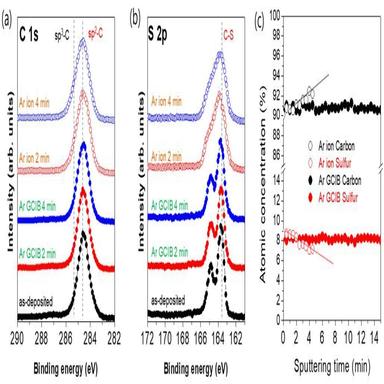
(a) C 1s and (b) S 2p XPS core level spectra and (c) atomic concentration depth profiles of pure poly(3-hexylthiophene) film obtained using continual Ar ion and Ar gas cluster ion beam sputtering.